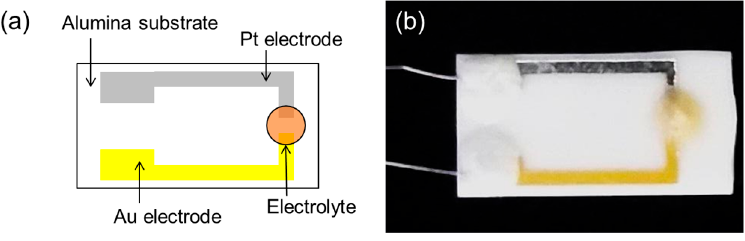
Figure 1. The structure of the sensor: ( a ) schematic illustration; and ( b ) optical image.